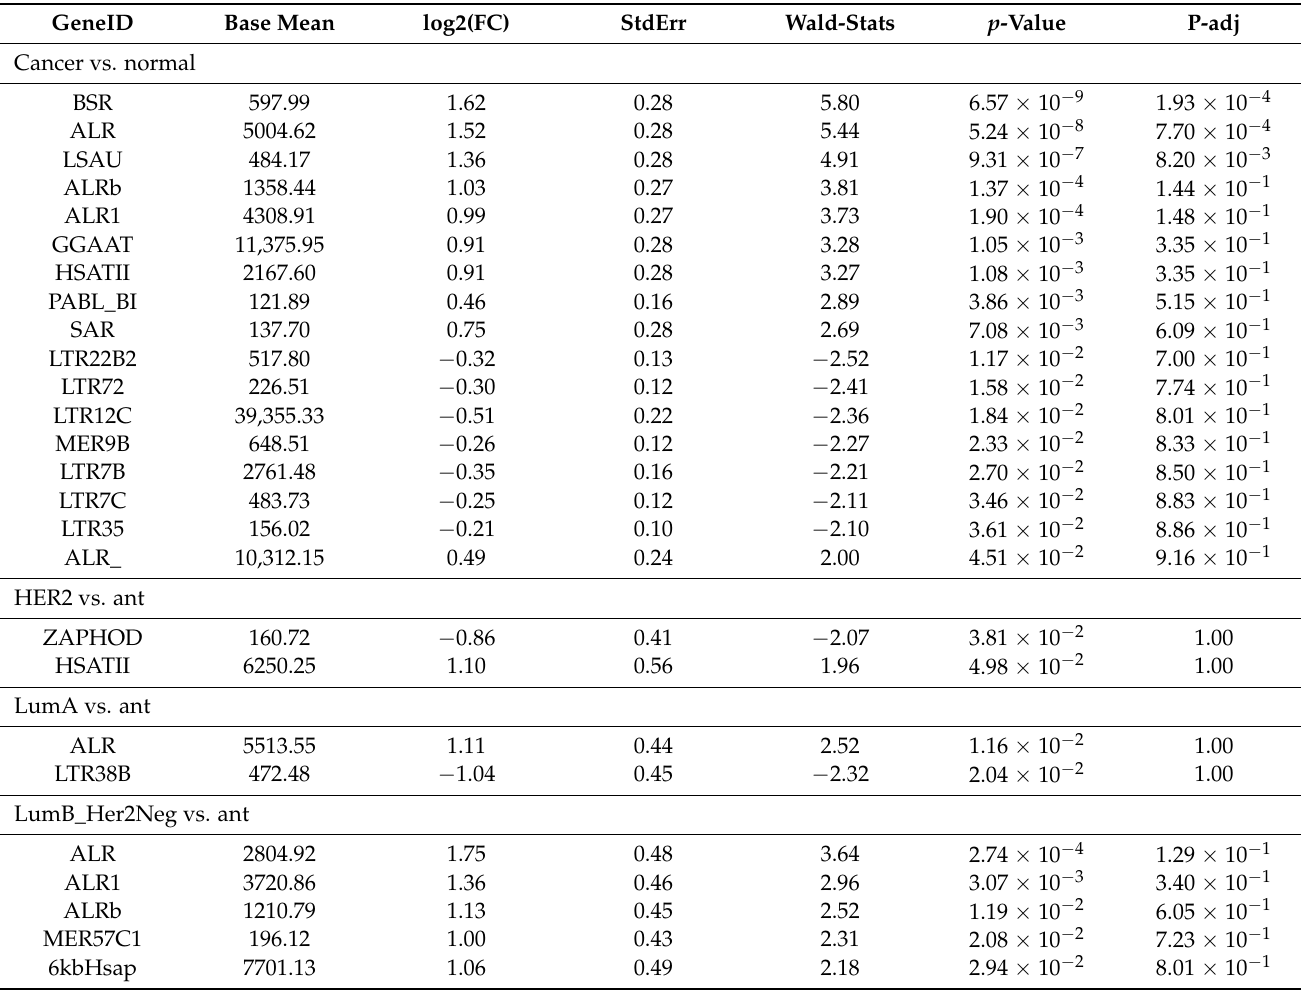
Table 1. A comparison between the 15 invasive breast cancer specimens and 18 controls (cancer vs. normal) and between each histotype with its adjacent non-cancerous tissues highlighted a panel of RS differentially expressed in the two conditions. The RS whose mean expression is above 100 and with a p -value < 0.05 are